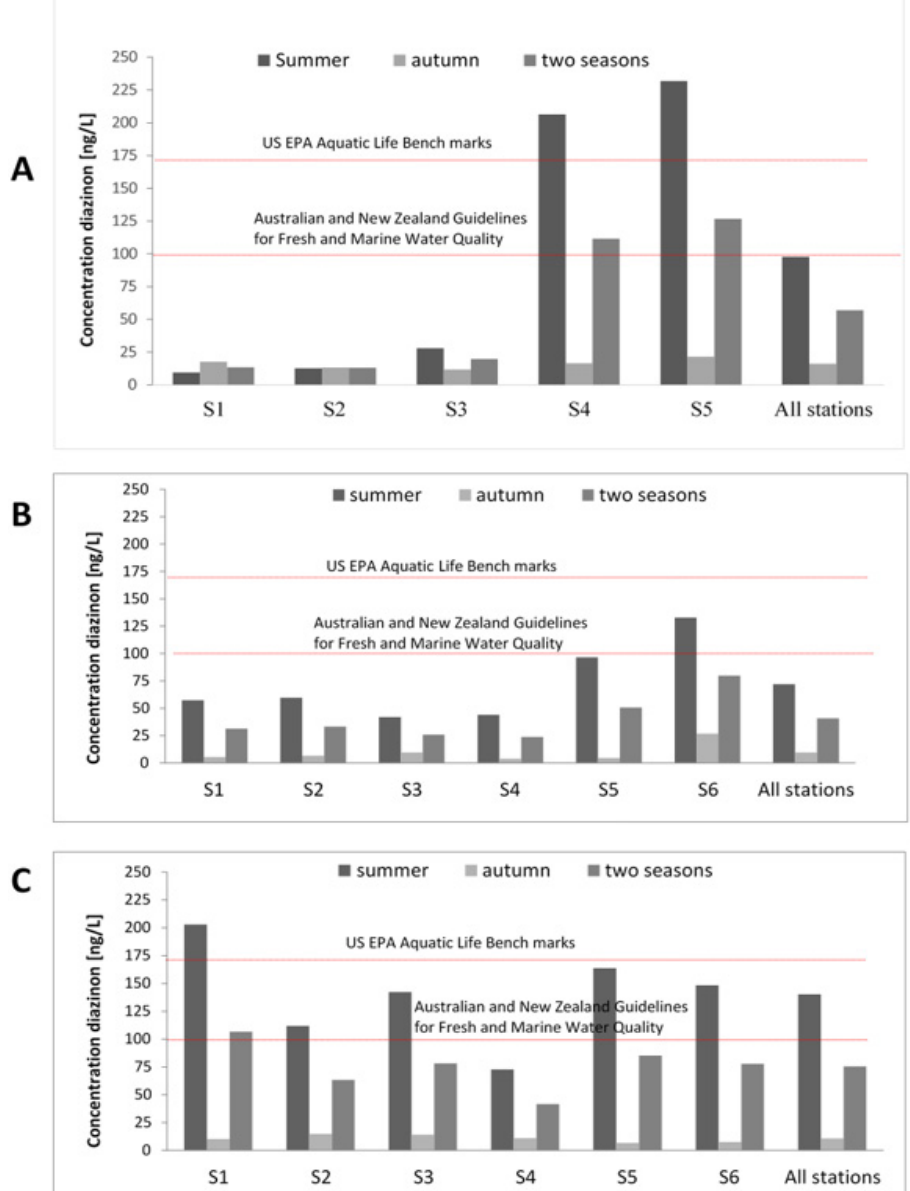
Figure 5. Mean concentration of diazinon in the surface water of the Haraz ( A ), Talar ( B ) and Babolrood ( C ) rivers in comparison to trigger values established under US EPA Aquatic Life Benchmarks (170 ng/L) and the Australian and New Zealand Guidelines for Fresh and Marine Water Quality (100 ng/L).